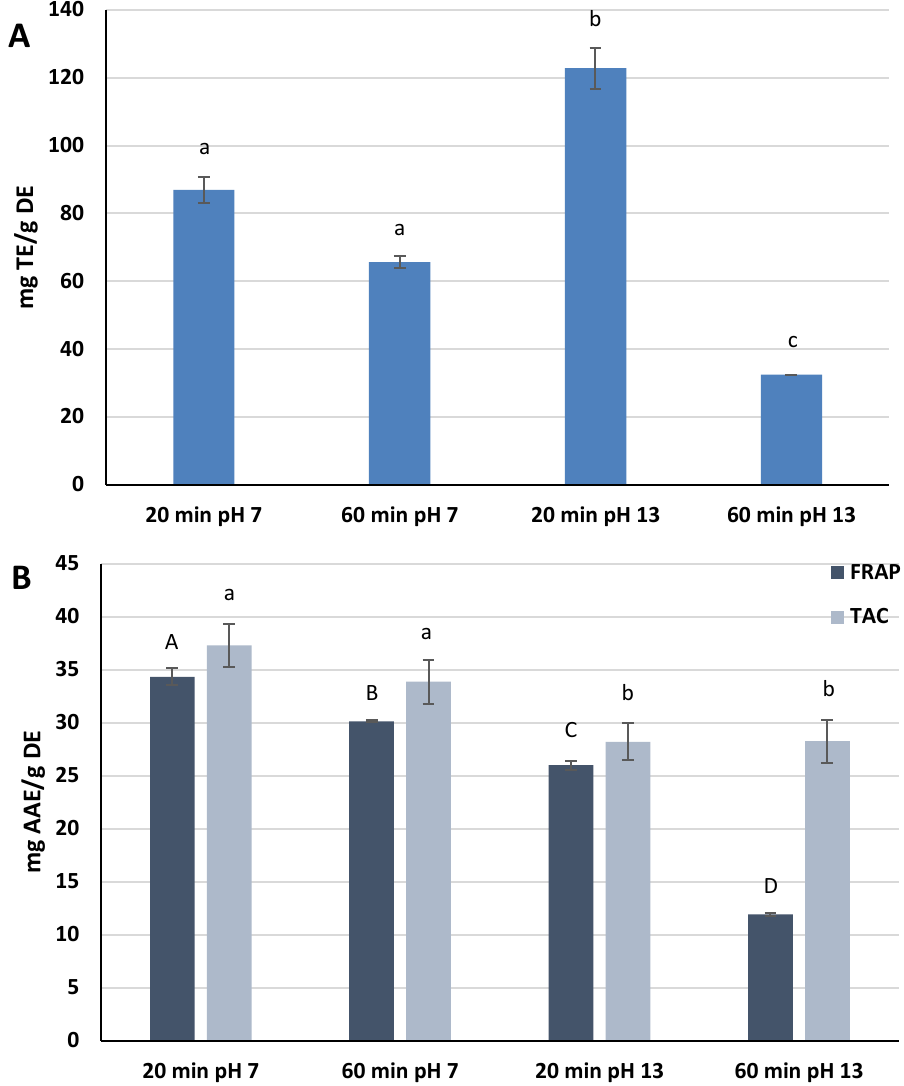
Figure 1. Radical Scavenging Activity ( A ), Ferric Reducing Antioxidant Power and Total Antioxi- dant Capacity ( B ) of “Greco” grape cane dry extracts. TE = Trolox Equivalents; DE = Dry Extract; AAE = Ascorbic Acid Equivalents. All determinations were performed in triplicate and results were expressed as mean ± SD. Bars with different letters denote significant statistical differences at p < 0.05.